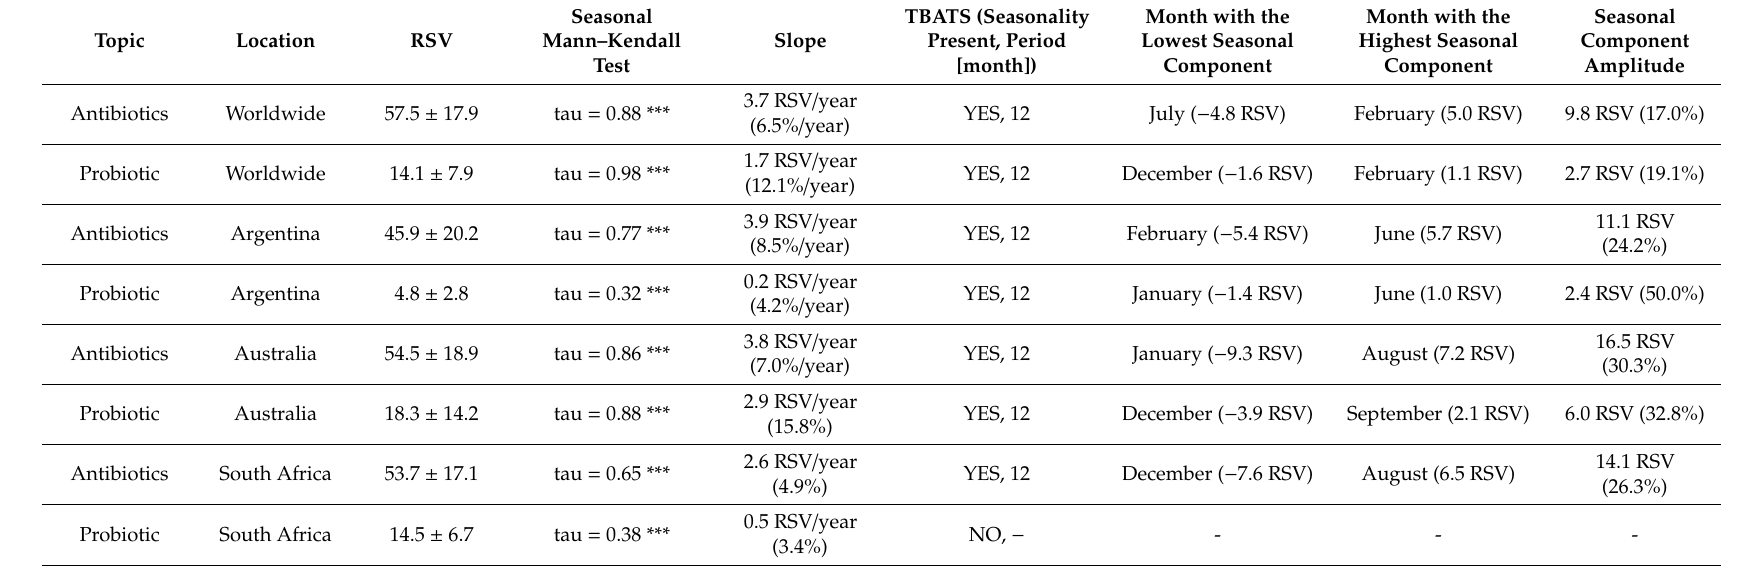
Table 1. Time series analysis of the topics. Relative search volume (RSV) presented as mean ± standard deviation. TBATS—exponential smoothing state space model with Box-Cox transformation, autoregressive-moving average errors, and trend and seasonal components. * p < 0.05, ** p < 0.01, *** p < 0.01.